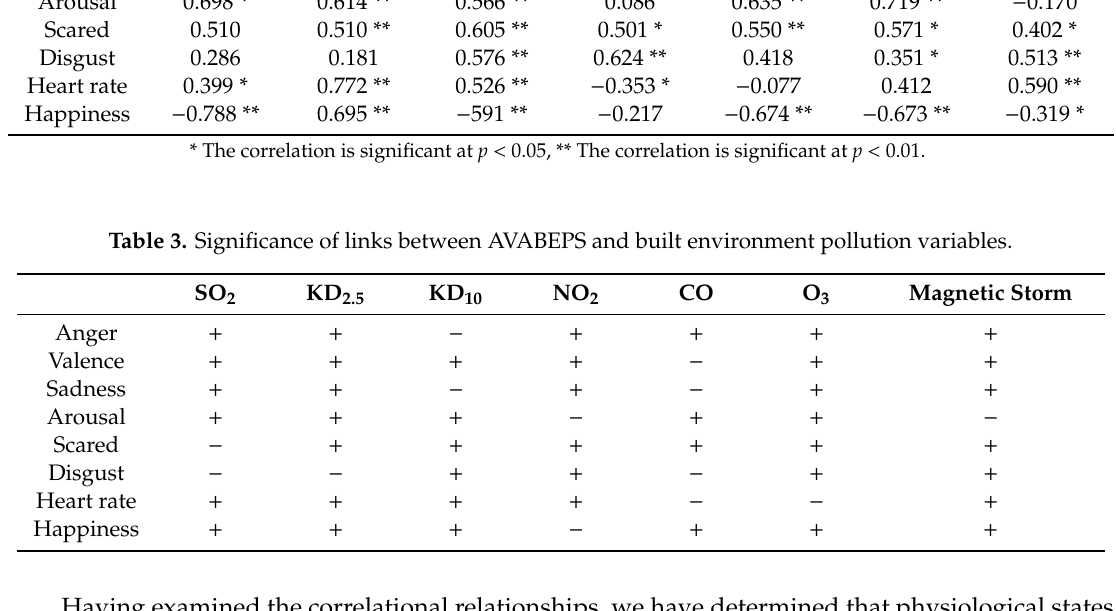
Figure 3. The dependency between average daily ( a ) heart rate and KD 10 , ( b ) heart rate and KD 10 , ( c ) heart rate and NO 2 , ( d ) arousal and SO 2 , ( e ) arousal and KD 10 , ( f ) arousal and KD 10 , ( g ) arousal and CO, ( h ) arousal and CO, ( i ) happiness and magnetic storm, ( j ) happiness and magnetic storm based on the values measured at six Vilnius intersections. Table 2. AVABEPS and built environment pollution correlational analysis results. SO 2 Table 1. A database snippet with AVABEPS variables of passers-by recorded at four intersections in Vilnius.